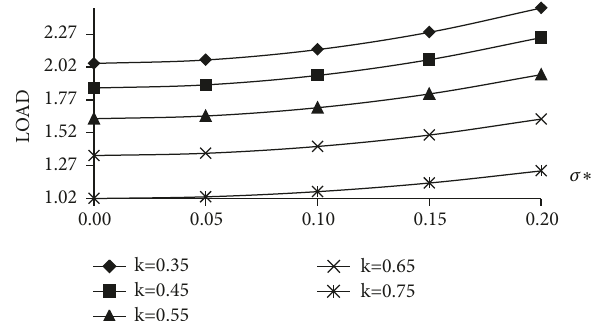
Figure 13: Profile of load with respect to 𝜎 ∗ and k.